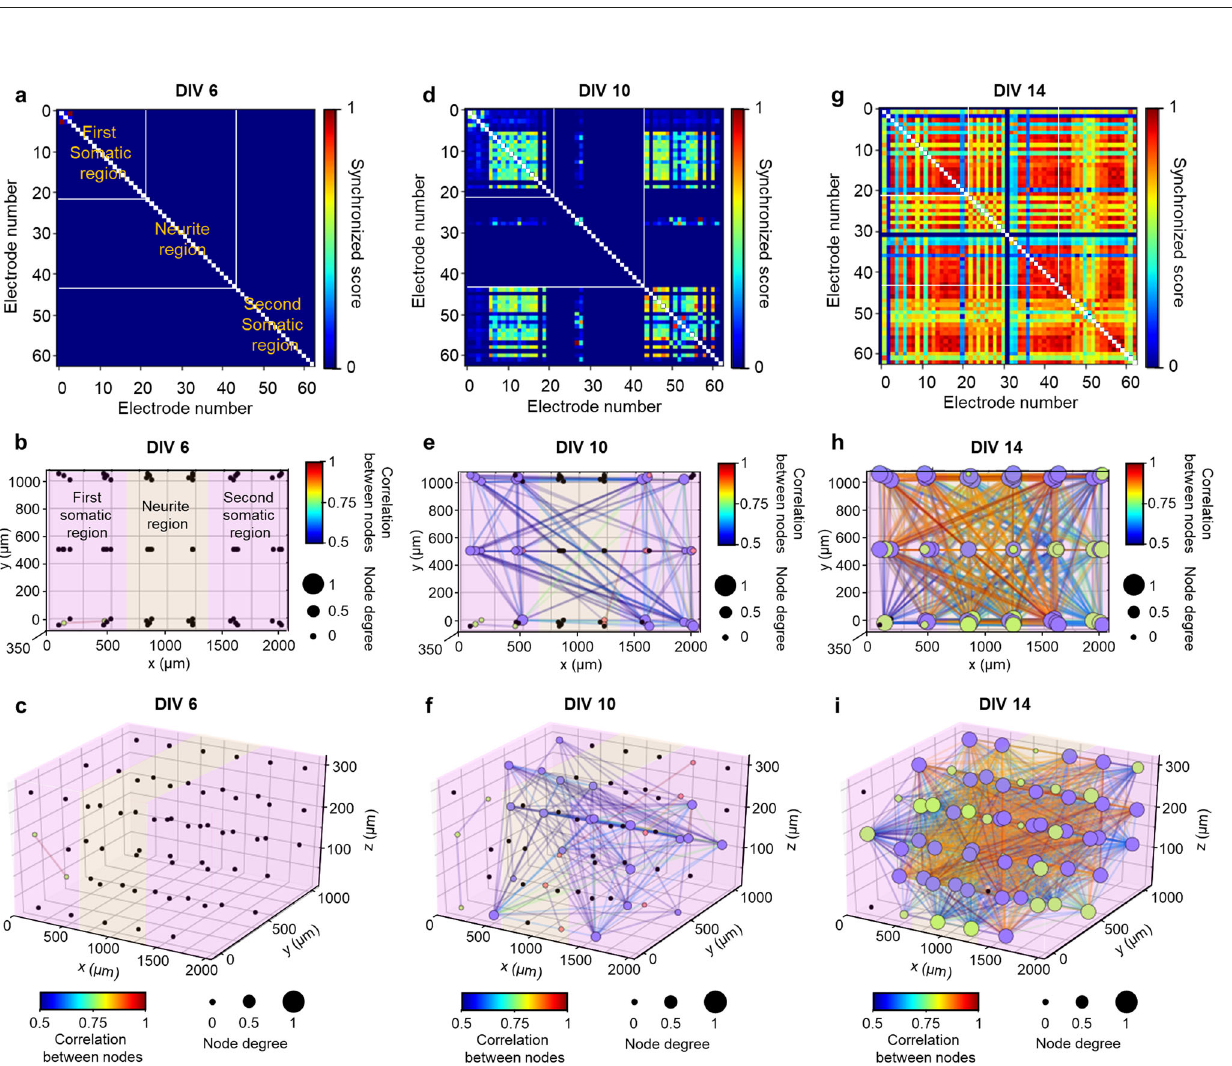
Fig. 5 Analysis of functional connectivity between compartmentalized somatic regions in the two-group 3D neural network model. a Schematic illustrations of the 3D multifunctional MEA inserted in the compartmentalized 3D neural tissue consisting of two somatic regions (pink) and a neurite region (orange). Six shanks are positioned in each region, and the multifunctional shank is located near a corner of the fi rst somatic region. The blue rectangle indicates the onset of light. b – d Changes in neural activities by locally optical stimulation at days in vitro (DIV 6) in the two-group 3D neural network model. b Raster plots displaying neural activities recorded from 63 electrodes of the 3D MEA within the compartmentalized regions during local optical stimulations (0.2 Hz, 50% duty cycles). The light blue rectangle indicates the onset of light. The dark blue rectangle represents the electrodes on the light-transmitted multifunctional shank. c 3D visualization of shank map in the compartmentalized neural network model (top) and z -averaged, color- mapped increase in fi ring rate during LED on-cycles, compared with that during LED off-cycles (bottom), corresponding to sub-regions near each shank as depicted in the top panel. Black indicates no signals recorded from the electrodes. d Firing rate of 3D cultured neurons at the stimulation site, in the fi rst somatic, neurite, and the second somatic regions during LED off (white)-cycle and on (blue)-cycle of the optical stimulations (* P = 0.0443 at the stimulation site; ns P = 0.3409 in the fi rst somatic region). e – g Changes in neural activities by locally optical stimulation at DIV 10 in the two-group 3D neural network model. e Raster plots; ( f ) 3D visualization of shank map and z -averaged, color-mapped increase in fi ring rate during LED on-cycles; ( g ) Firing rate of 3D cultured neurons at each region (* P = 0.0220 at the stimulation site; * P = 0.0444 in the fi rst somatic region; ns P = 0.4506 in the neurite region; * P = 0.0436 in the second somatic region). h – j Changes in neural activities by locally optical stimulation at DIV 14 in the two-group 3D neural network model. h Raster plots; ( i ) 3D visualization of shank map and z -averaged, color-mapped increase in fi ring rate during LED on-cycles; ( j ) Firing rate of 3D cultured neurons at each region (* P = 0.0218 at the stimulation site; * P = 0.0229 in the fi rst somatic region; * P = 0.0214 in the neurite region; * P = 0.0228 in the second somatic region). Data are presented as mean values + / − s.d. with individual data points (white circle; n = 6 stimulation trials for all data). Statistical signi fi cance was tested with a two-tailed unpaired t -test. Source Data is available as a Source Data fi le for Fig. 5b – j.